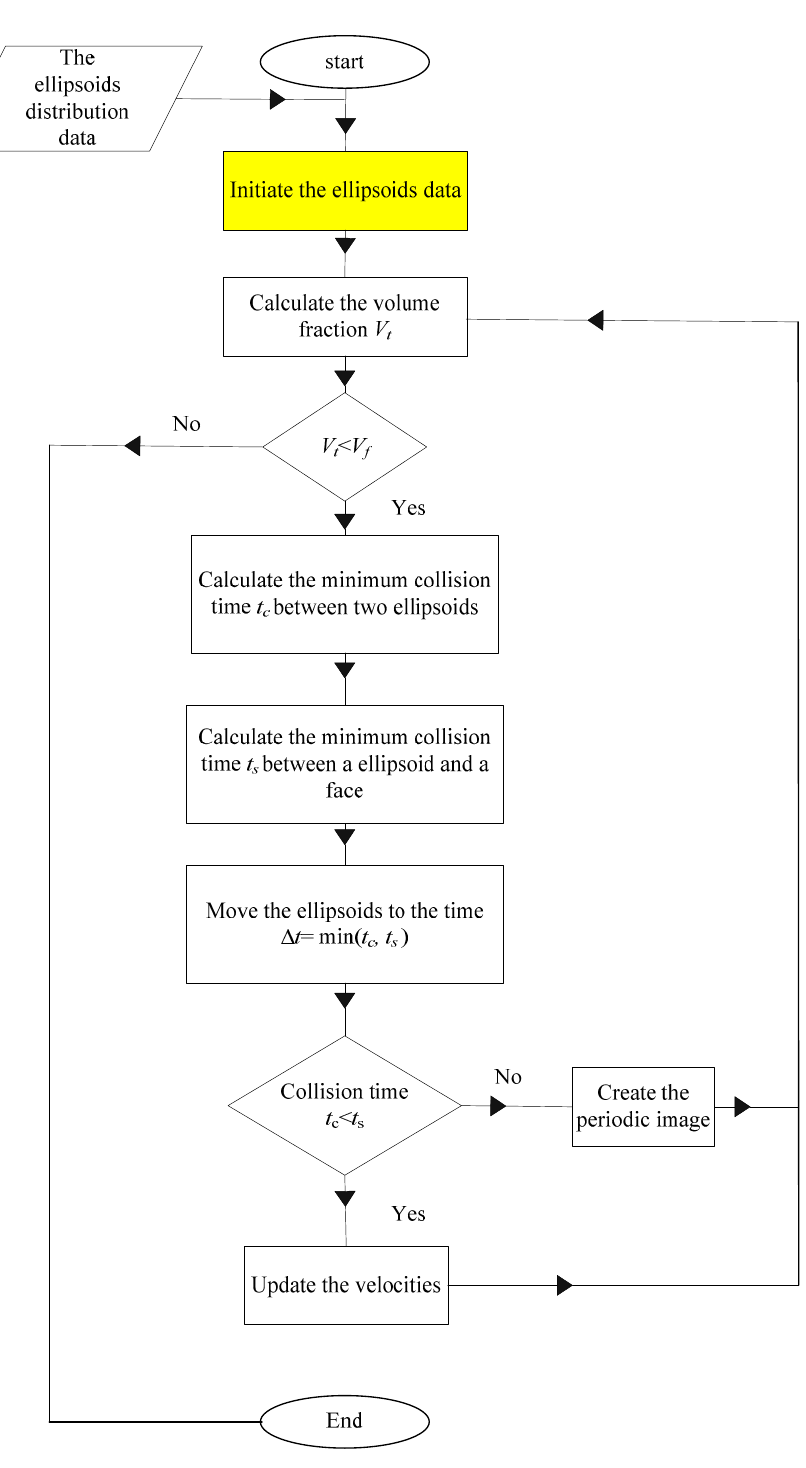
Figure 3. Flowchart of the generation of the periodic random packing of ellipsoids.